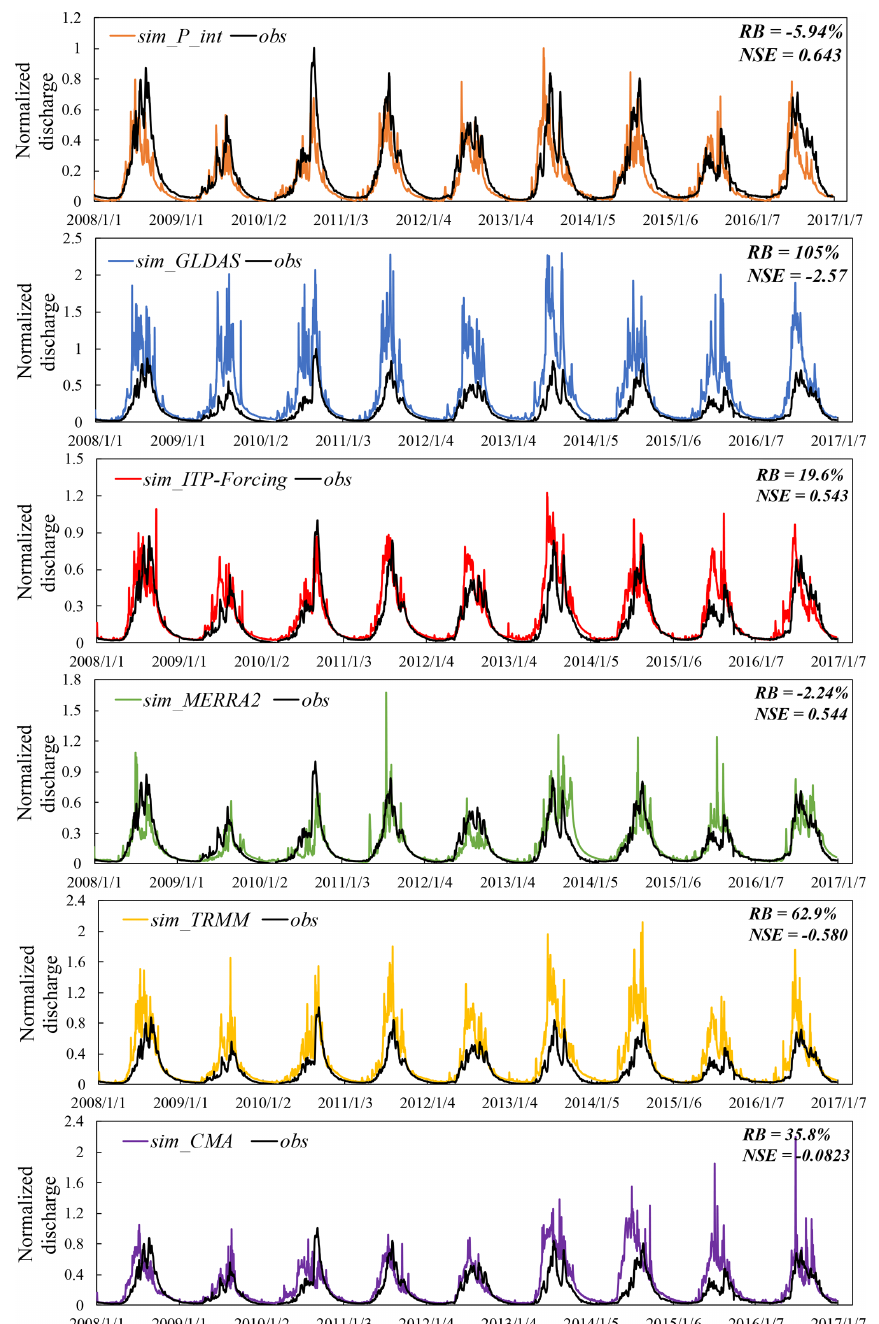
Figure 14. An evaluation of simulated daily discharge at Nuxia station from 2008 to 2016 forced by different precipitation products. All the discharge values have been